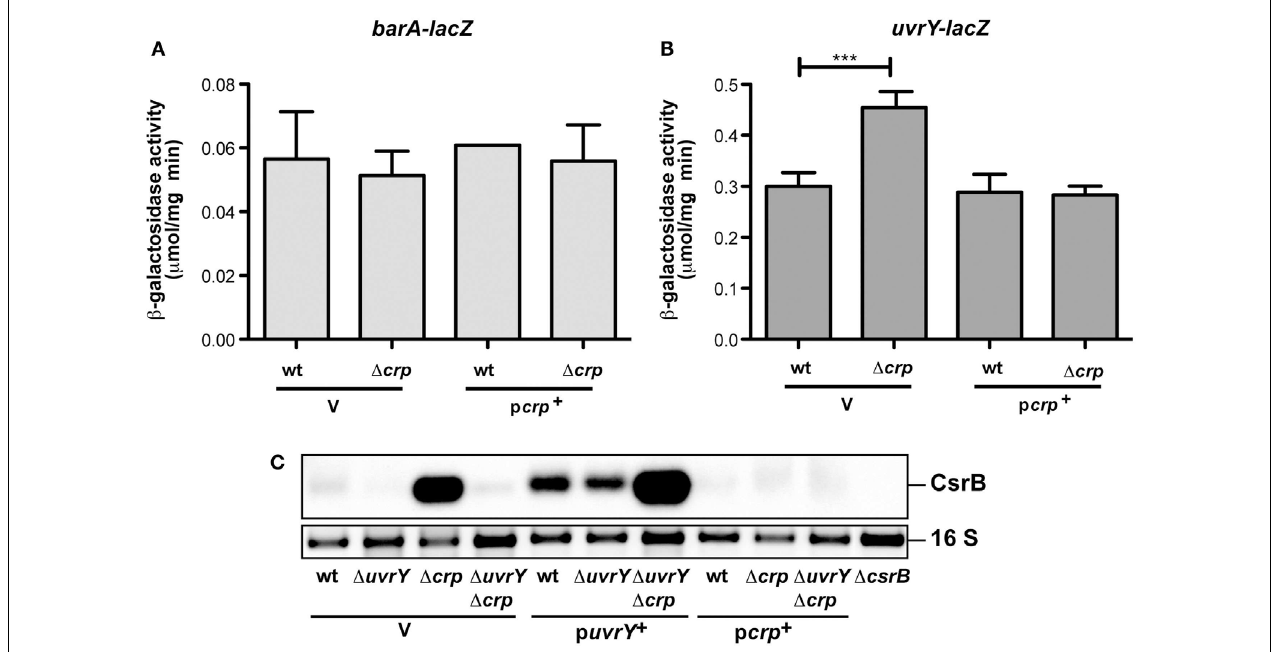
at least three different experiments each done in duplicate. (C) Expression of CsrB in the presence and absence of UvrY and/or Crp.Total RNA of Y. pseudotuberculosis wildtype strainYPIII and the mutant strainsYP89 ( ∆ crp ), YP120 ( ∆ uvrY ), andYP128 ( ∆ crp ∆ uvrY ) harboring the empty vector pAKH85 or the uvrY -encoding plasmid pAKH75 or crp -encoding plasmid pAKH37 grown at 25˚C was prepared, and analyzed by northern blotting with a CsrB-specific probe.YP69 ( ∆ csrB ) was used as negative